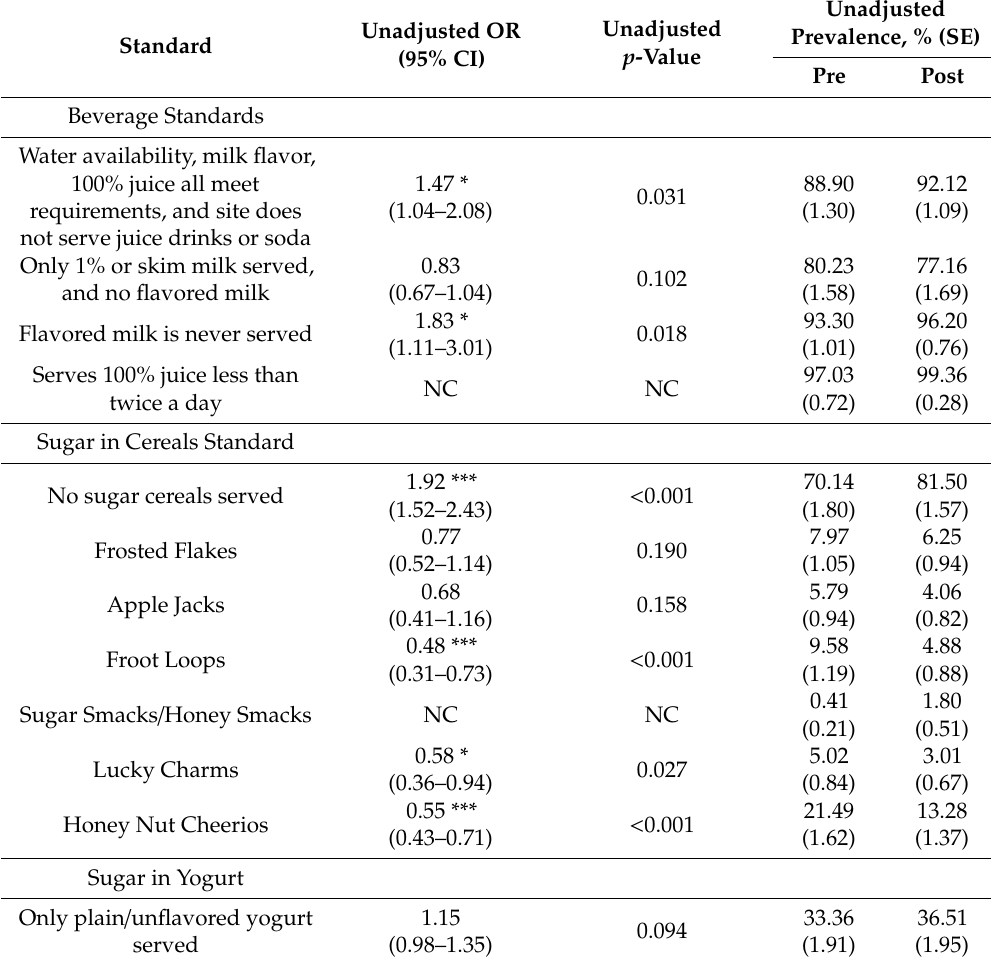
Table A2. Progress in meeting selected CACFP standards (unadjusted models), 2017–2019.